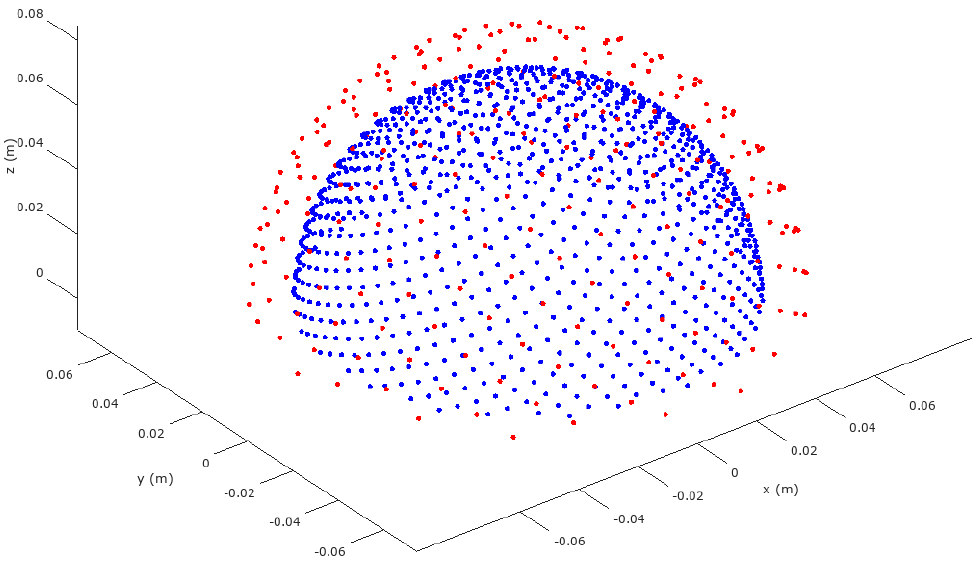
Figure 2. Candidate source and EEG electrodes in spherical head model (upper hemisphere, sources in blue, EEG electrodes in red).